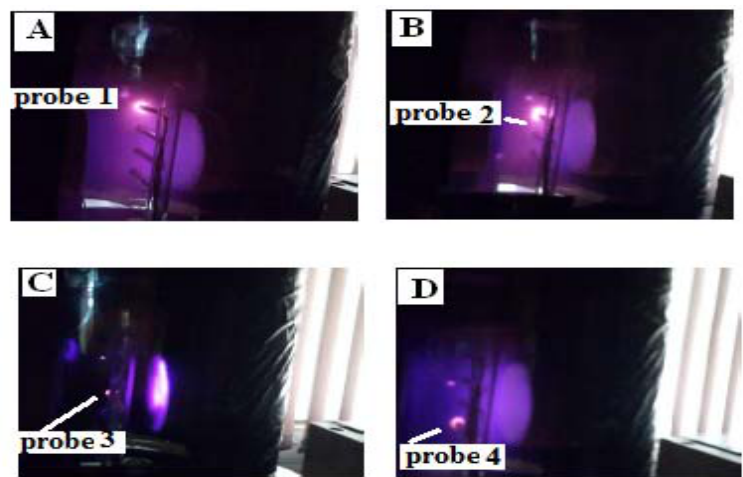
Fig.6: Photograph of the probeA, B, C and D at distance (1, 3, 5 and 7) cm with dust (Fe